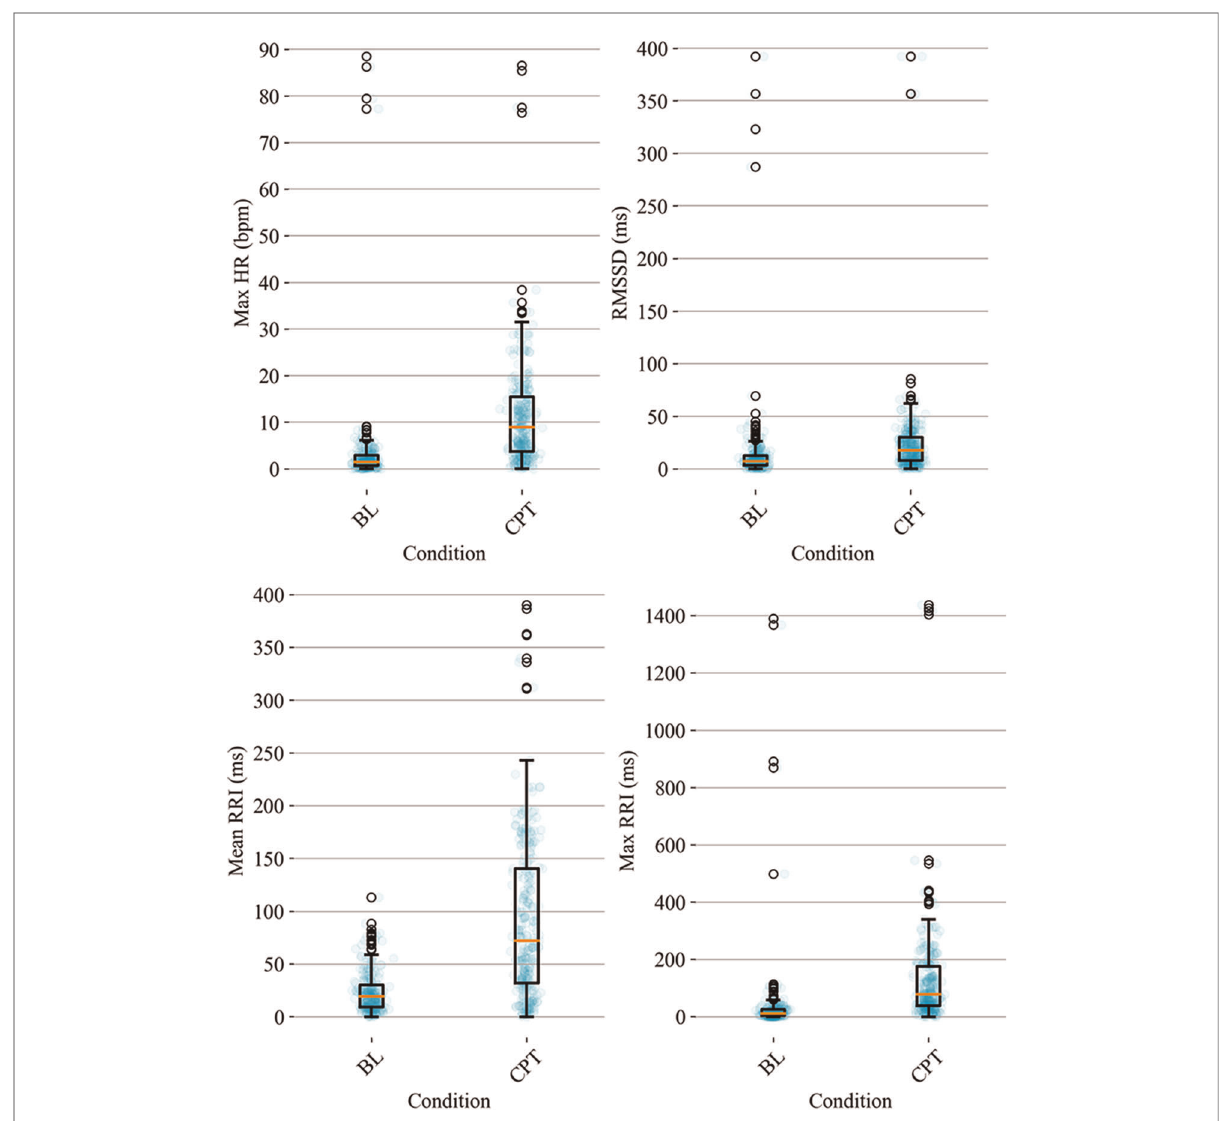
FIGURE 3 Baseline-normalized, HRV time domain features contributing most to the model included maximum HR, RMSSD, mean RRI, and max RRI. The data overlay on each boxplot represents the entire dataset (blue circles) used to generate the corresponding boxplot with medians shown in red and outliers shown as black